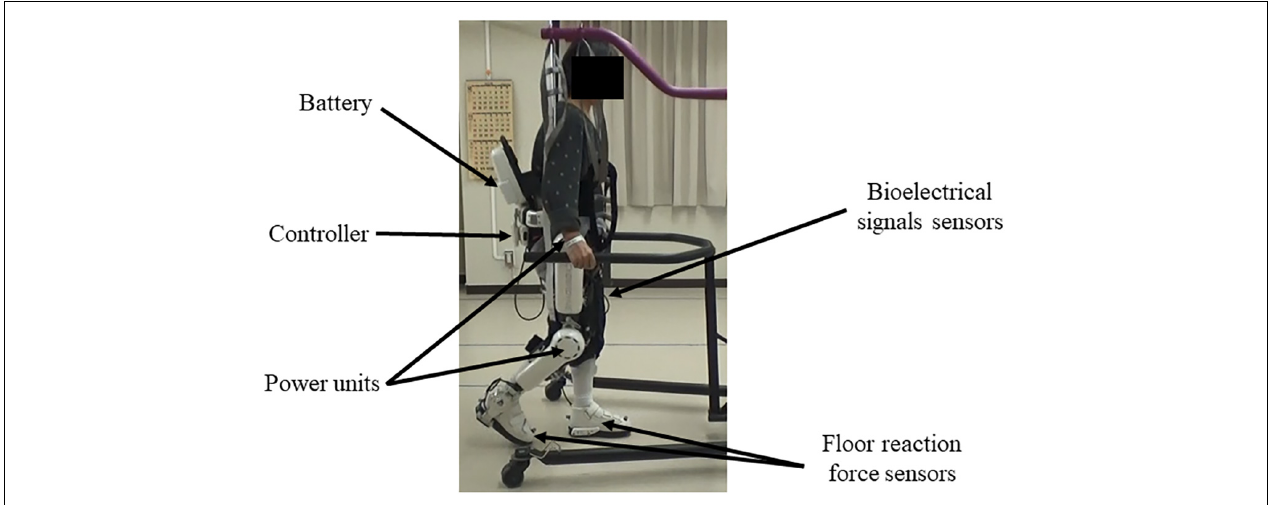
FIGURE 1 | Example of gait treatment using the wearable cyborg HAL on the paretic lower limb. HAL is composed of an exoskeletal frame, power units, a battery, a controller, BES sensors, and floor reaction sensors, together with belts to secure the waist, thigh, and lower leg. HAL, Hybrid Assistive Limb; BES, bioelectrical